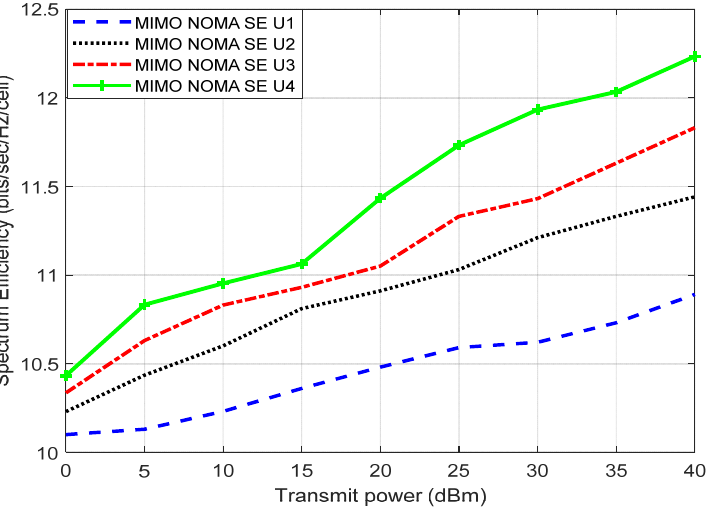
Figure 7. SE vs. transmitting power for 4 users’ 64 × 64 MIMO DL-NOMA PD.